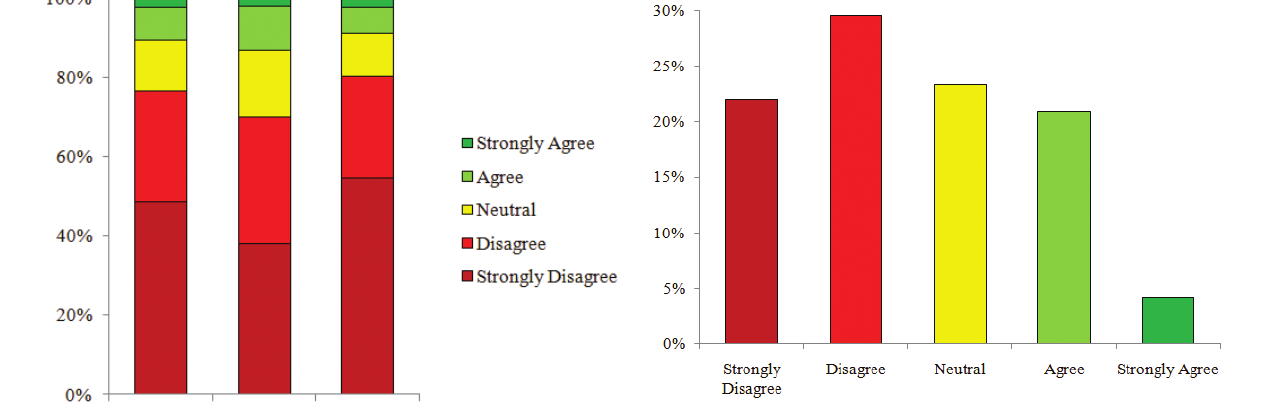
Figure 10. Cumulative responses to A1: “Based on Bangla - desh’s current socio-economic condition, it is possible to main - tain nuclear power in a safe, secured, and sustainable